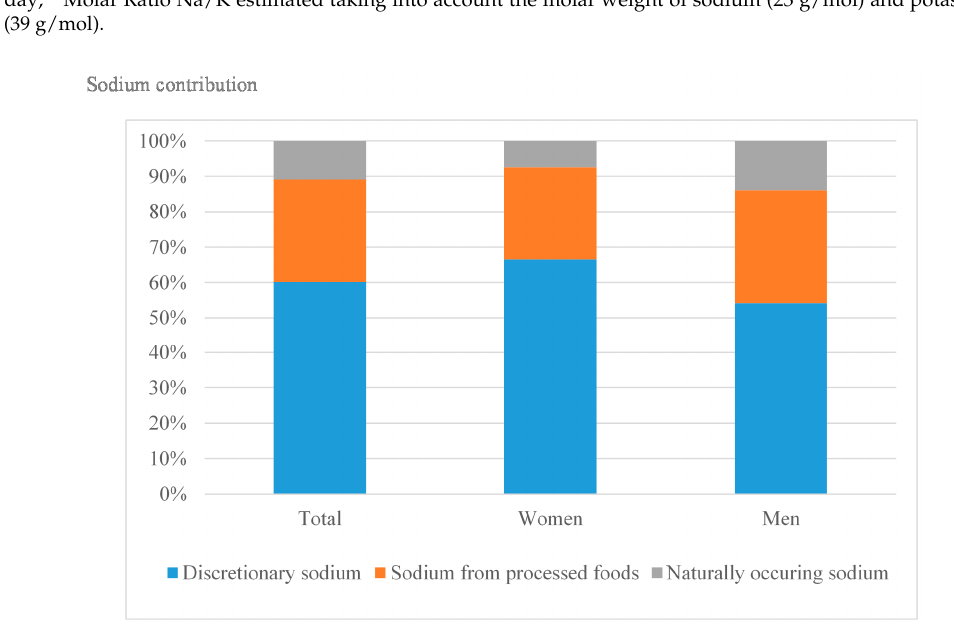
Figure 1. Mean sodium contribution (%) from discretionary salt use (added sodium during culinary preparations), salt added during processing (sodium from processed foods) and sodium intrinsic in food (naturally occurring sodium), overall and by sex.